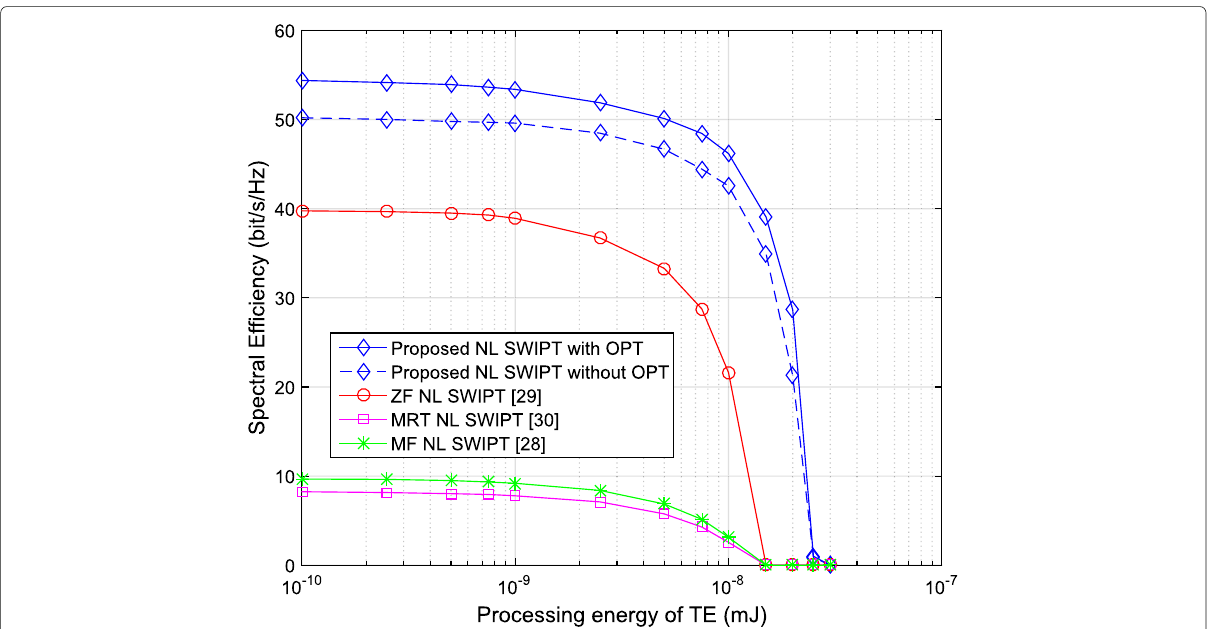
Fig. 6 Spectral efficiency of the proposed SWIPT protocol with the varying of the processing energy of TE, the channel coherent time is 300 symbols, N = 256. The transmit power of the BS is set to 46 dBm